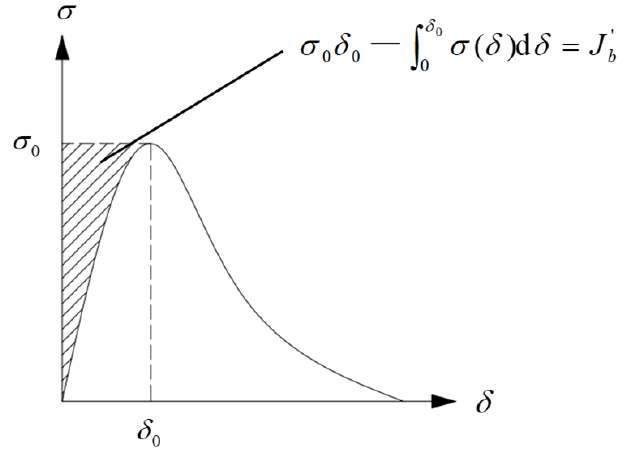
Figure 9. Relationship between the crack opening width and bridging-fiber stress.